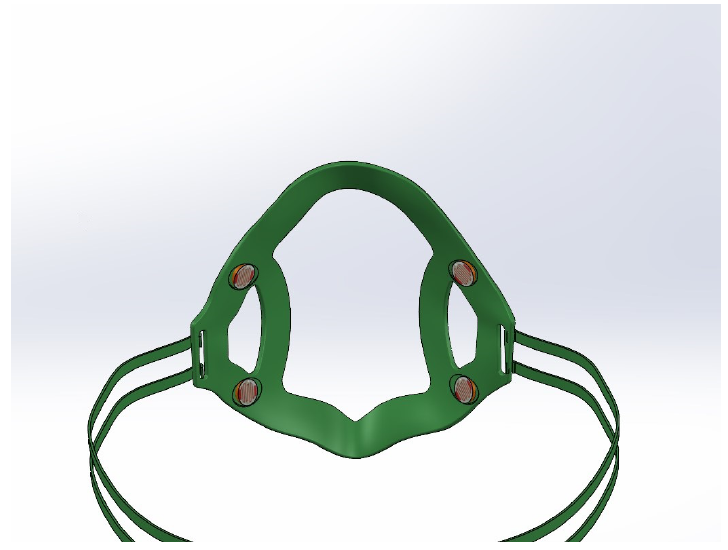
Figure 4. Mask brace with LDR